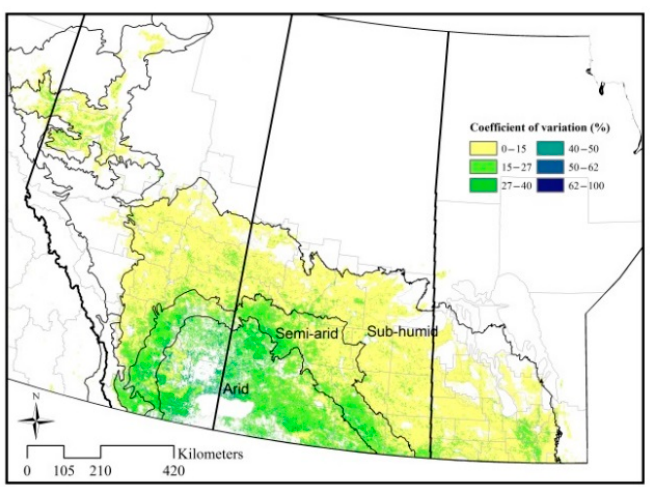
Figure 12. The coefficient of variation (CV) about the temporal variation of annual CFAPAR during the period of 2000–2013.